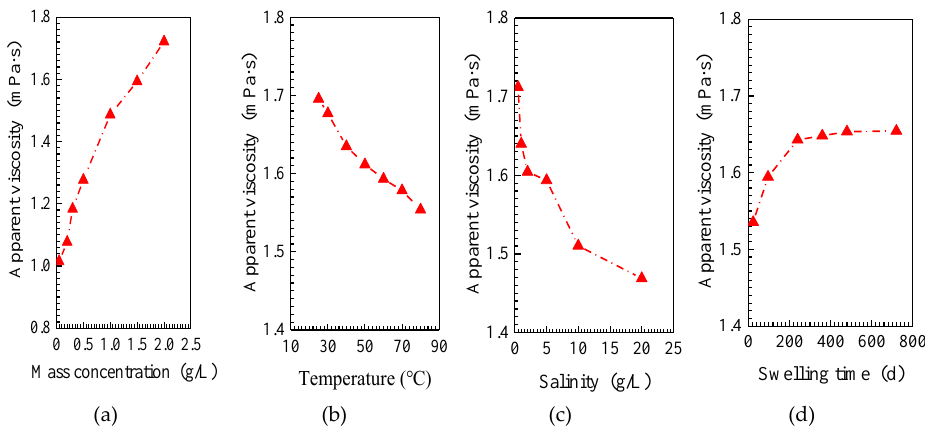
Figure 5. Effect of mass concentration ( a , T = 60 °C, TDS = 5 g/L, and t = 120 h), temperature ( b , C = 1.5 g/L, TDS = 5 g/L, and t = 120 h), salinity ( c , T = 60 °C, C = 1.5 g/L, and t = 120 h), and swelling time ( d , T = 60 °C, C = 1.5 g/L, and TDS = 5 g/L) on viscosity properties of SiO 2 /P(MBAAm- co -AM) suspension. The apparent viscosities of the SiO 2 /P(MBAAm- co -AM) suspension with respect to shear rate are presented in Figure 6 at various mass concentrations of SiO 2 /P(MBAAm- co -AM) nanoparticles, temperatures, salinities, and swelling times. Under all experimental conditions, the apparent viscosity of the SiO 2 /P(MBAAm- co -AM) suspension versus shear rate follows a similar trend. At lower shear rates, the apparent viscosity of the SiO 2 /P(MBAAm- co -AM) suspension decreases with an increase of shear rate, and we can consider the behavior of the SiO 2 /P(MBAAm- co -AM) suspension as non-Newtonian. At shear rates greater than 300 s − 1 , the constant apparent viscosity of the SiO 2 /P(MBAAm- co -AM) suspension after changing shear rate indicates that the apparent viscosity does not depend on shear rate and represents Newtonian fluid behavior.